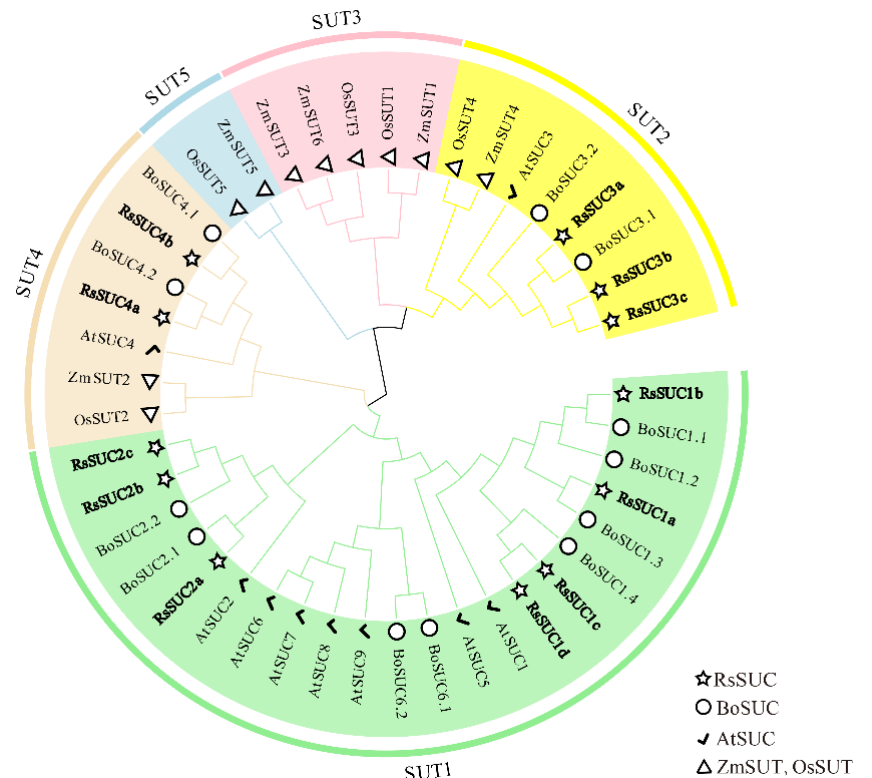
Figure 1. Phylogenetic analysis of SUC genes in radish, Arabidopsis , B. oleracea , O. sativa , and Z. mays . SUC proteins were divided into five subgroups (SUT1, SUT2, SUT3, SUT4, and SUT5), and each color group represented a subgroup. Stars, circles, checkmarks, and triangles represent SUC proteins in radish, B. oleracea , Arabidopsis , O. sativa , and Z. mays , respectively.